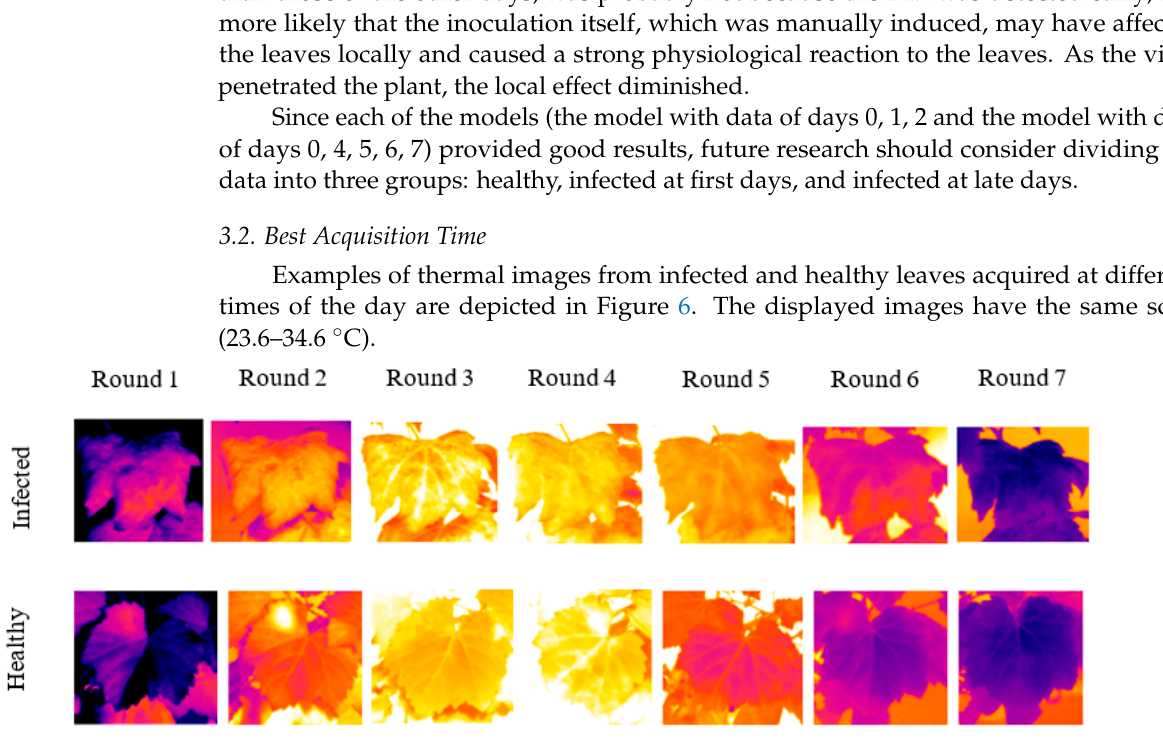
Figure 6. Thermal images from infected and healthy leaves acquired at different times of the day.